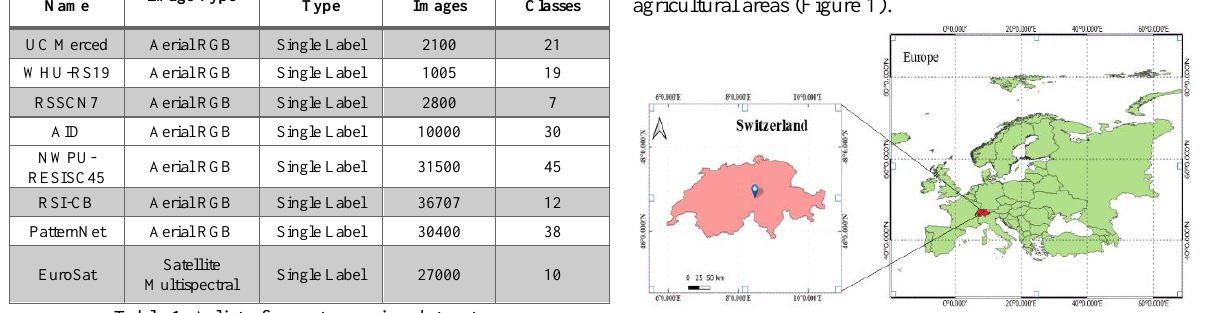
Figure 1. Location of study